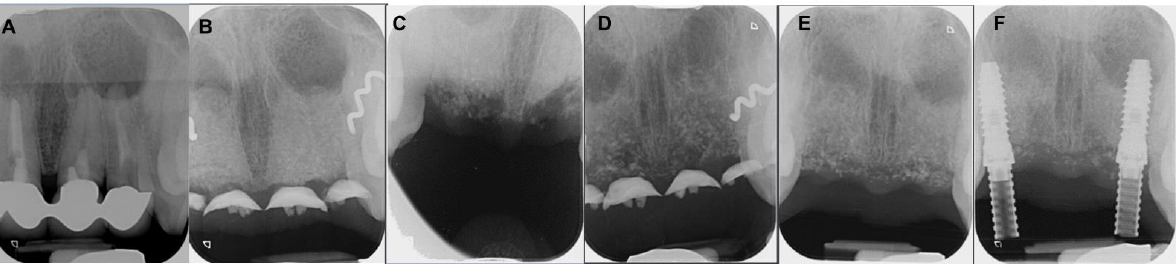
Figure 13. ( A ) Preoperative IOPA; ( B ) Immediate postoperative IOPA; ( C ) One-week IOPA; ( D ) One-month IOPA; ( E ) Two months IOPA; ( F ) IOPA after implant placement.